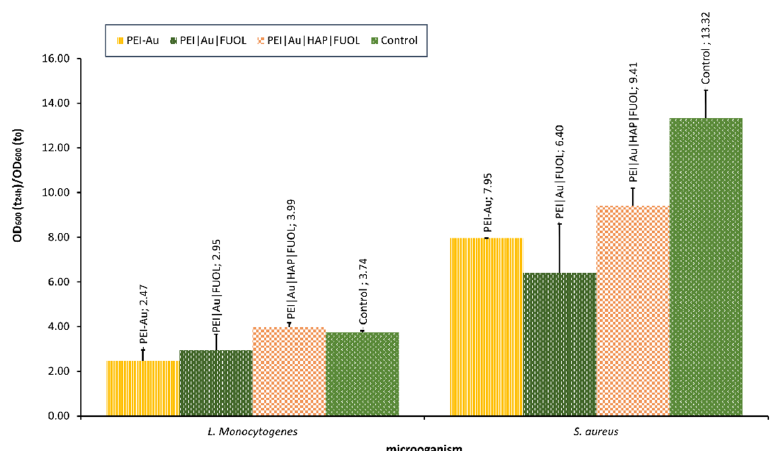
Figure 7. The optical density of bacterial strains L. monocytogenes and S. aureus after 24-h culture in